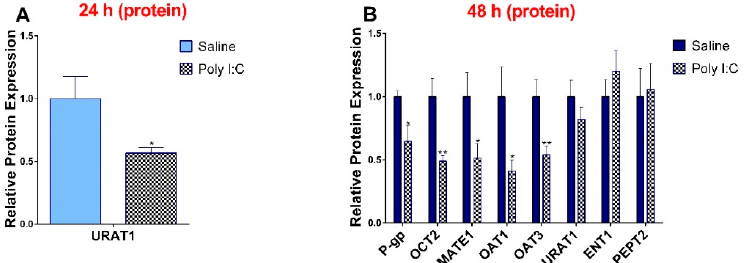
Figure 3. Poly I:C decreases protein expression of transporters at ( A ) 24 h and ( B ) 48 h after administration. Protein was extracted from kidneys at 24 and 48 h after i.p. administration of 10 mg / kg poly I:C or saline to pregnant rats at gestational day 14, as described in methods ( n = 7–8 / group). Results are expressed relative to saline control as mean ± S.E.M. Significance was determined using Student’s unpaired t -test (* p < 0.05, ** p <